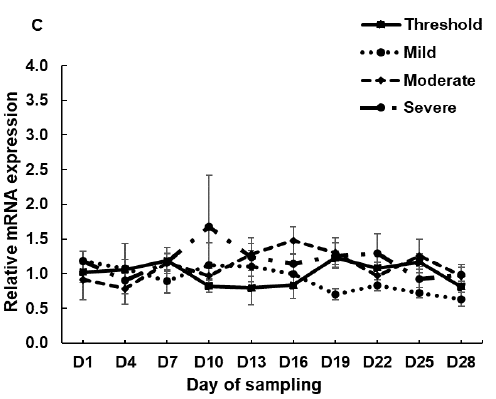
Figure 3. mRNA expression of ( a ), HSP70, ( b ) HSP90, and ( c ) HSPB1 in the PBMCs of calves during the climate chamber experiment. Data are presented as the means ± standards error (n = 4). a, b Means with different superscripts differ significantly ( p < 0.05) among the sampling dates based on Tukey’s test.